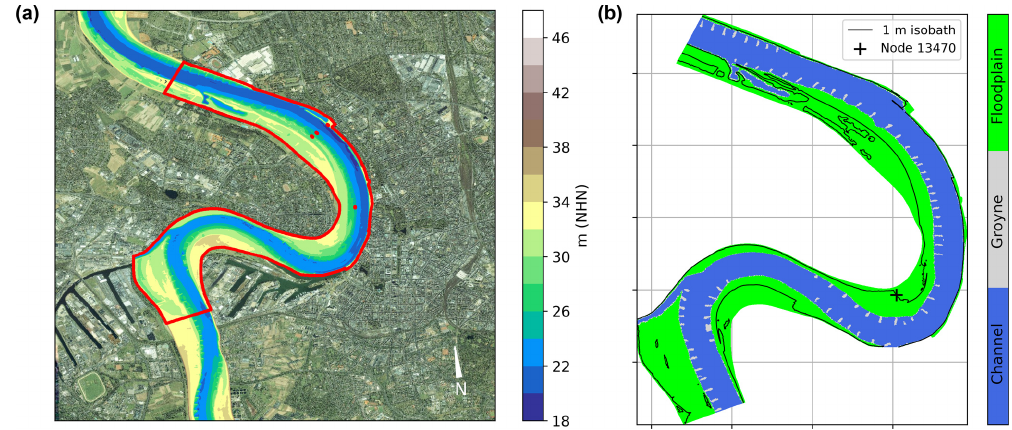
Figure 1. Lower Rhine river topography and numerical model boundaries (red polygon) nearby Düsseldorf (a) , and friction zones definition in the numerical model (b) . The flow direction is north. (Satellite image a is the intellectual property of Esri and is used herein under license. Copyright © 2019 Esri and its